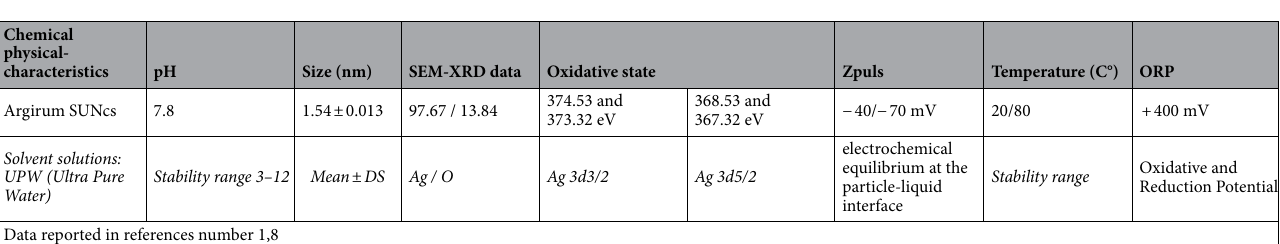
Table 1. Chemical–physical properties of Argirium SUNCs. Are present collected data of this manuscript and precedents for a detailed